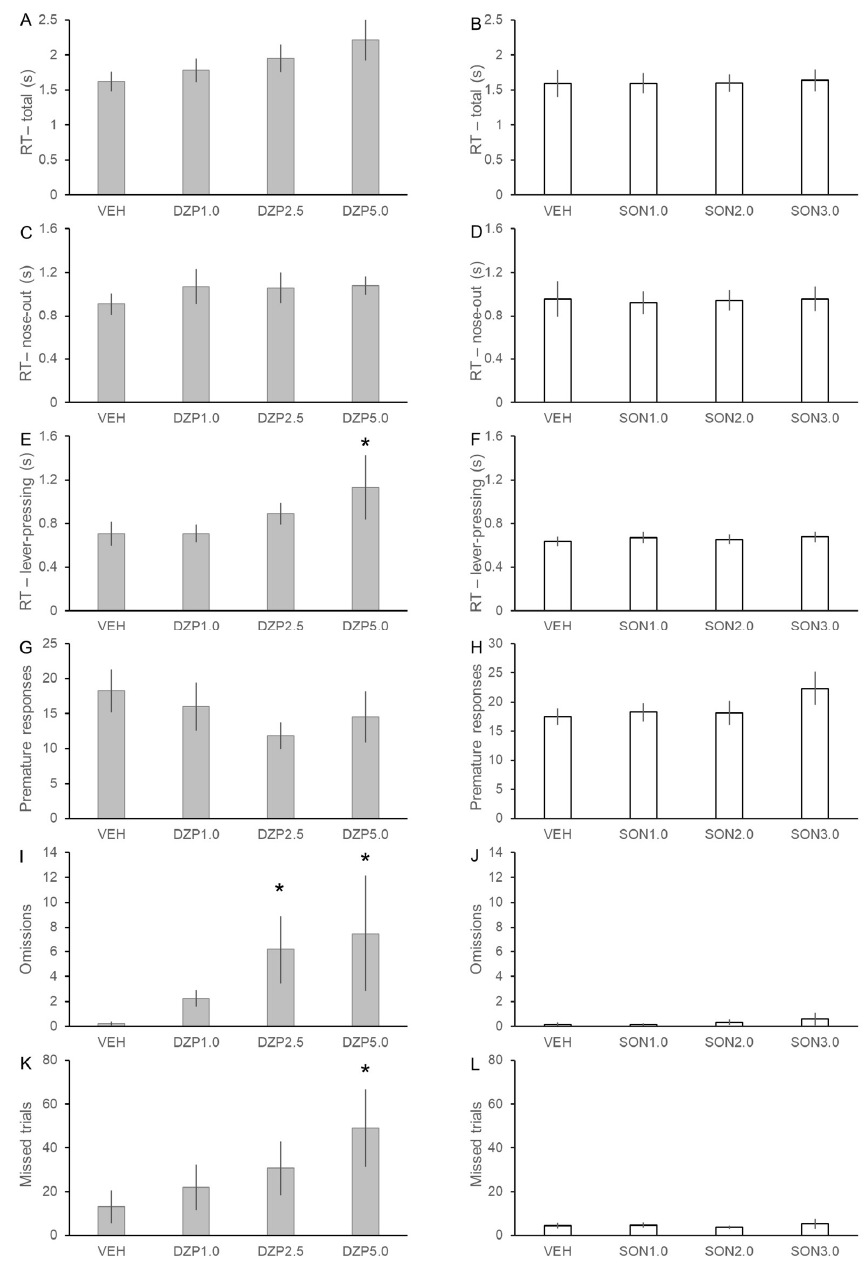
Figure 5. Effects of diazepam and songorine in the rat psychomotor vigilance task. Psychomotor speed was evaluated using the total reaction time (RT, panel ( A , B )) and its “nose-out” ( C , D ) and “lever-press” ( E , F ) components. Overall performance was evaluated by the number of premature responses ( G , H ), omissions ( I , J ), and missed trials ( K , L ). Data are expressed as mean ± SEM. VEH: vehicle, DZP1.0: 1.0 mg/kg diazepam, DZP2.5: 2.5 mg/kg diazepam, DZP5.0: 5.0 mg/kg diazepam, SON0.5: 0.5 mg/kg songorine, SON1.0: 1.0 mg/kg songorine, SON2.0: 2.0 mg/kg songorine.